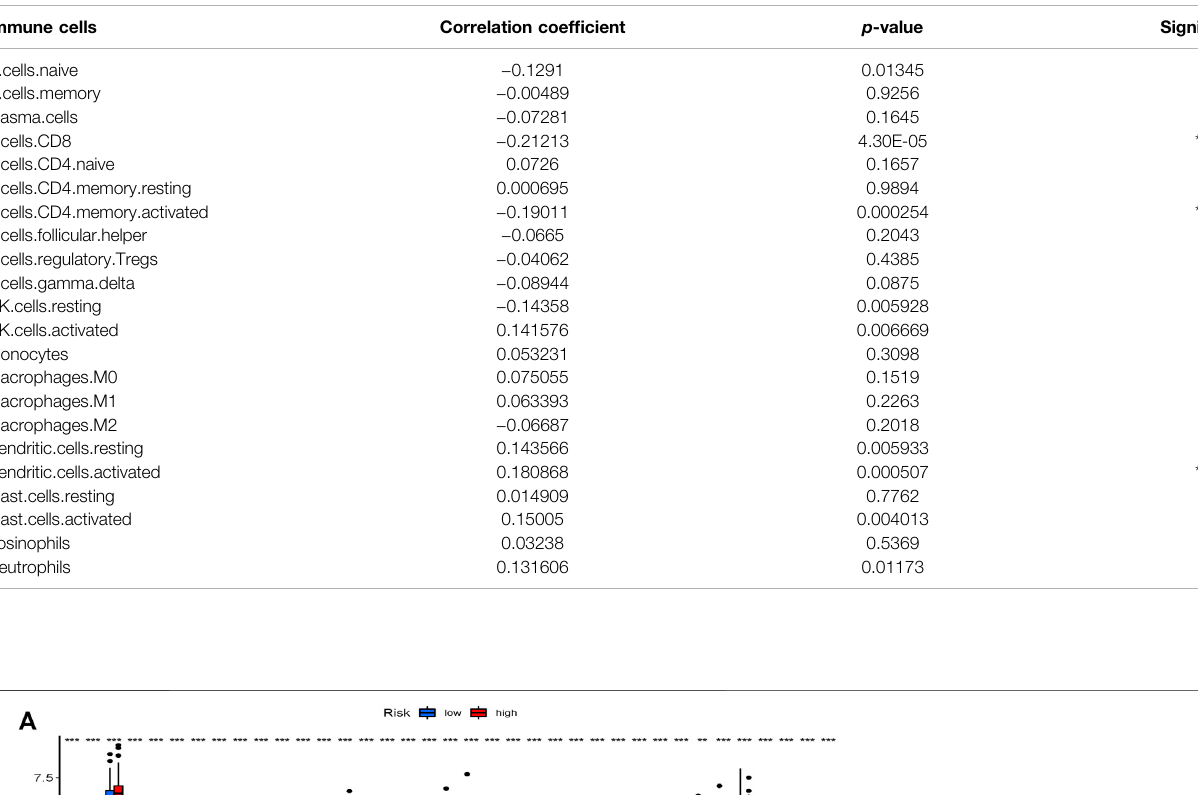
TABLE 2 | Correlation of immune cells and risk scores.